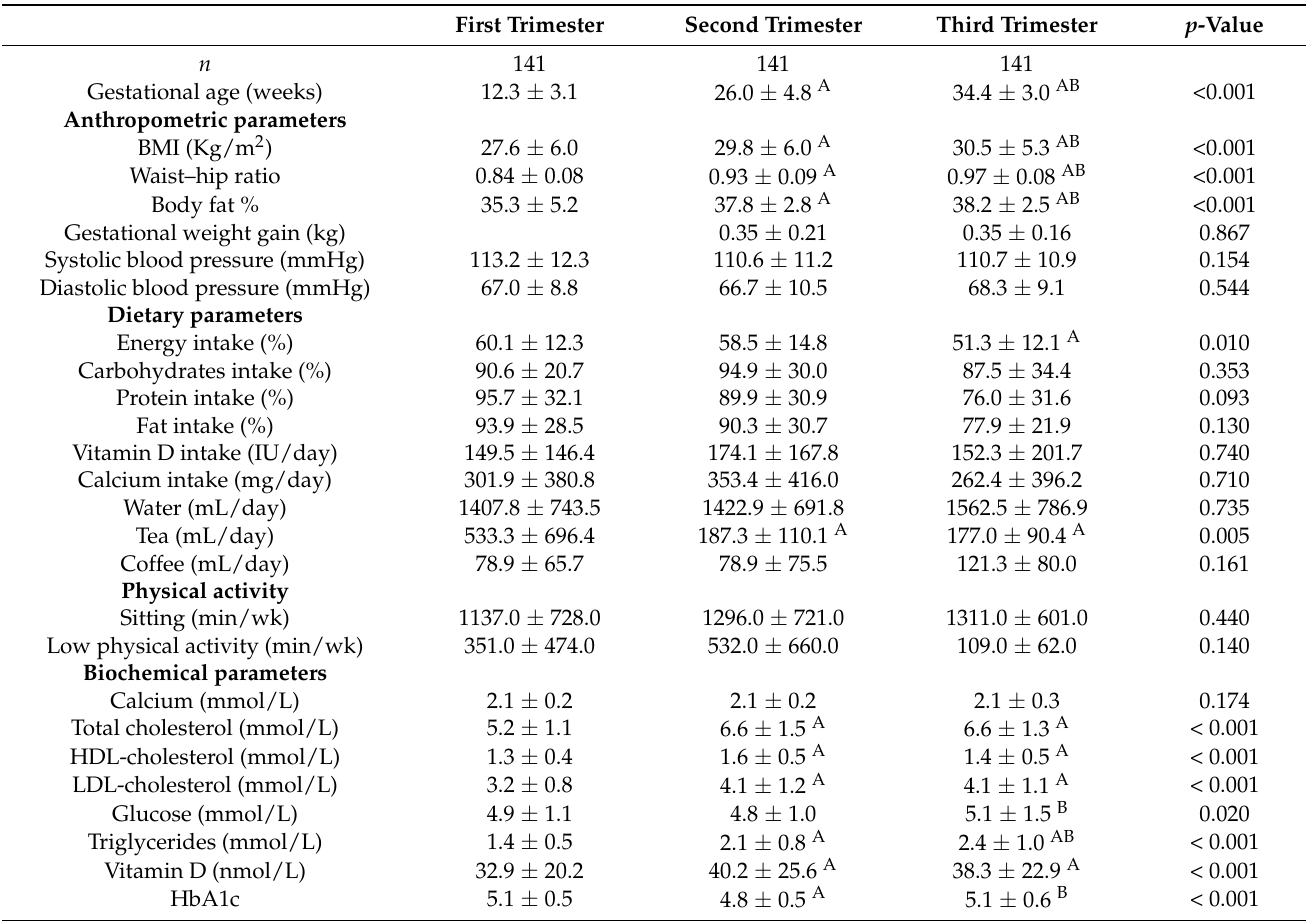
Table 2. Change in general parameters at the three visits.